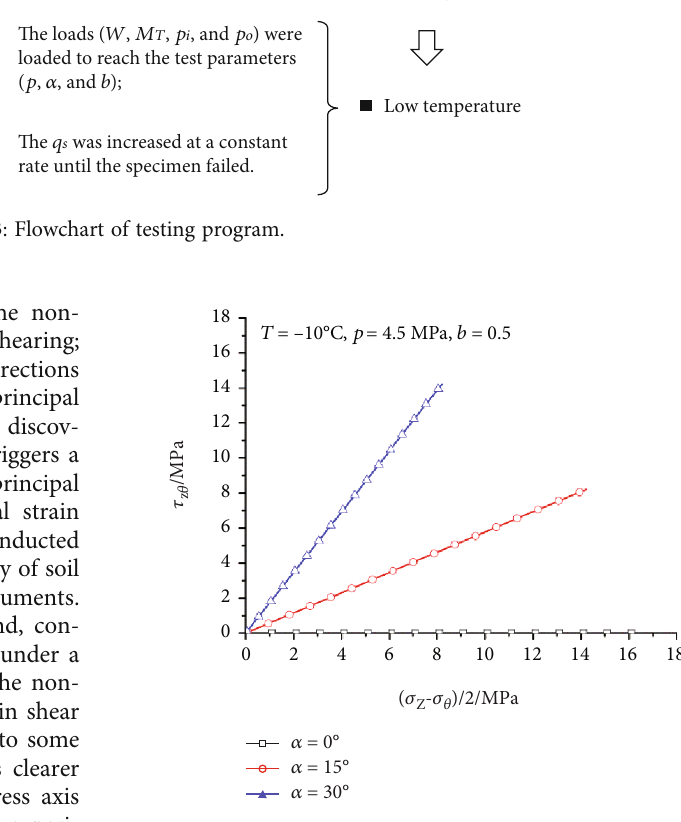
Figure 4: Stress path under di ff erent principal stress